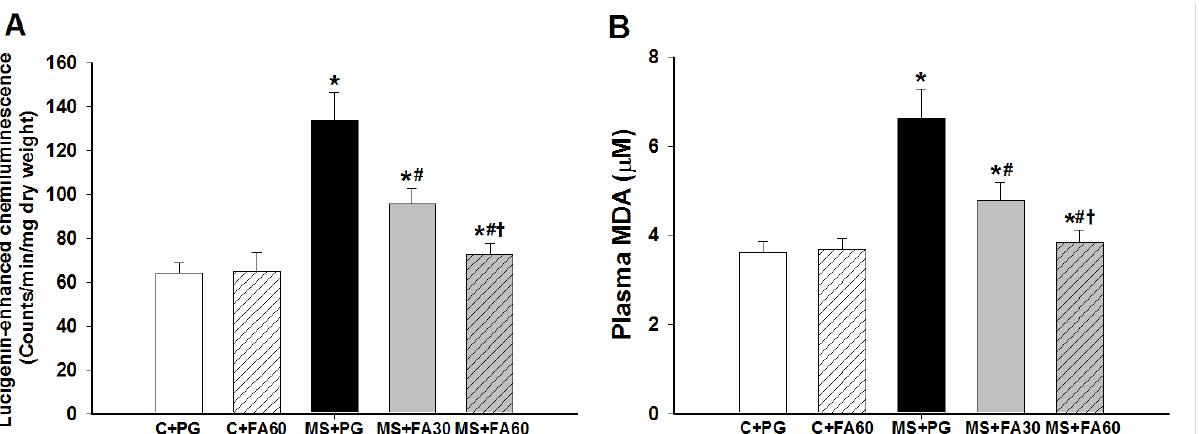
Figure 4. Effect of FA on superoxide and lipid peroxidation in MS rats. Superoxide